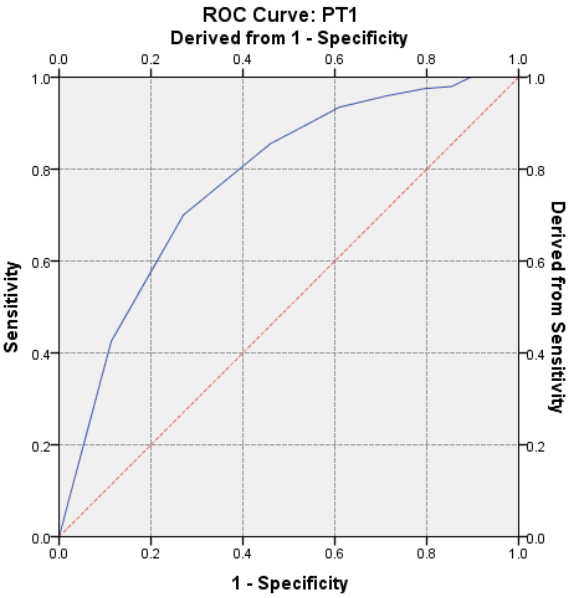
Figure 6. Receiver operator characteristic (ROC) curve on the assessment of hypercoagulability for the first the first determination.